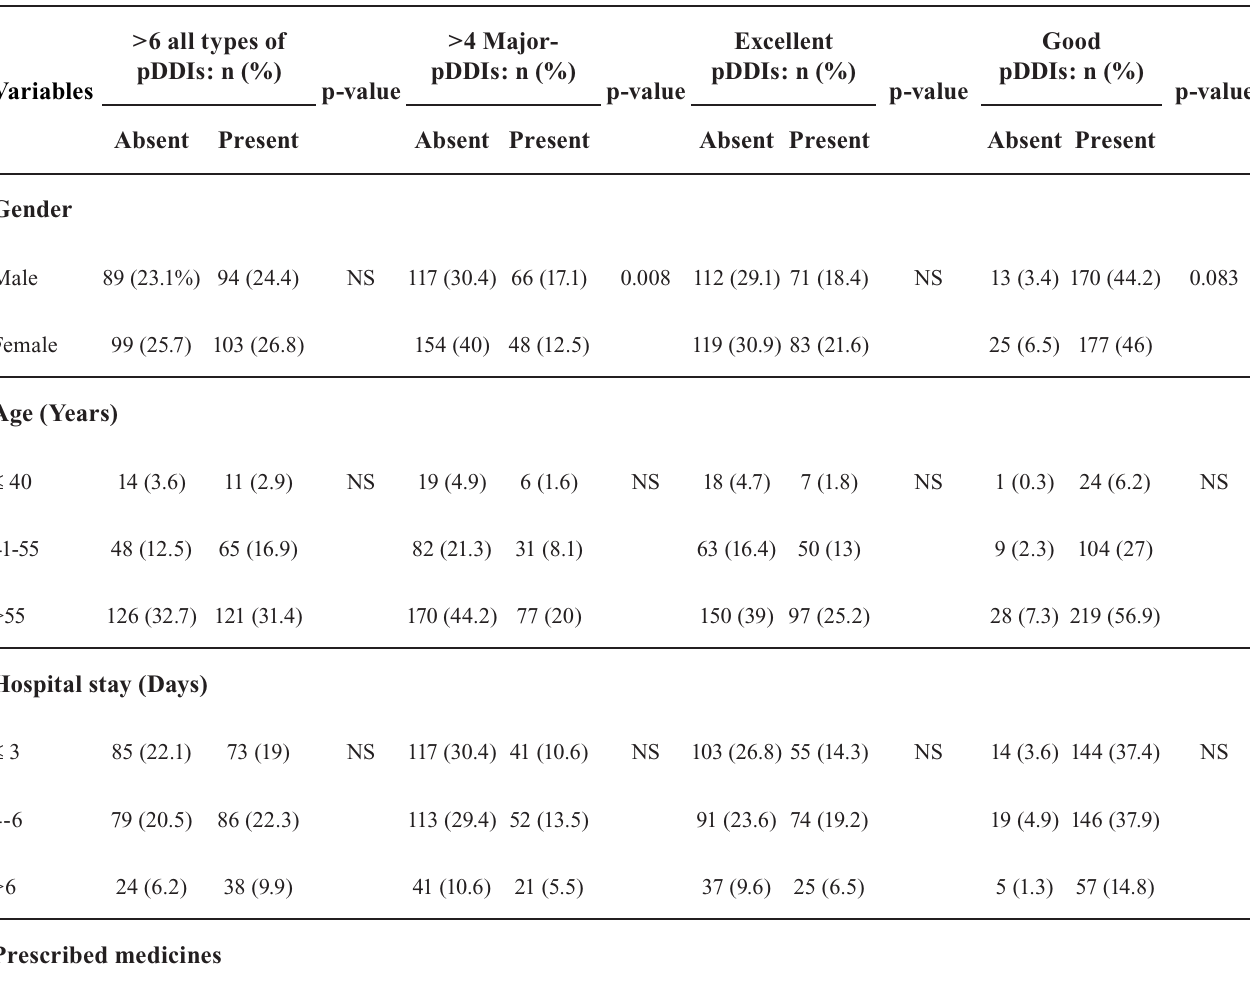
TABLE II - Exposure to potential drug-drug interactions and documentation levels, stratified according to patients’ characteristics